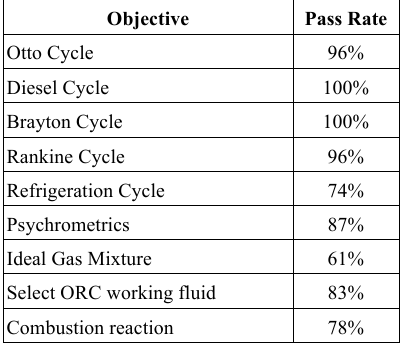
Table 1. Pass rate of individual learning objectives in a Thermodynamics Course